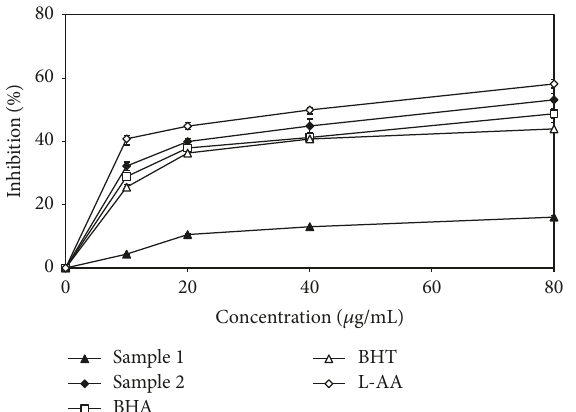
Figure 5: Thiobarbituric acid-reactive substances (TBARS) assay of extracts from the sarcocarp of C. multiflorus plus positive controls. Results are mean ± SD ( 𝑛 = 3 ). Sample 1: the sample extracted by ethanol-water (7: 3, v/v); Sample 2: the sample reextracted from Sample 1 by ethyl